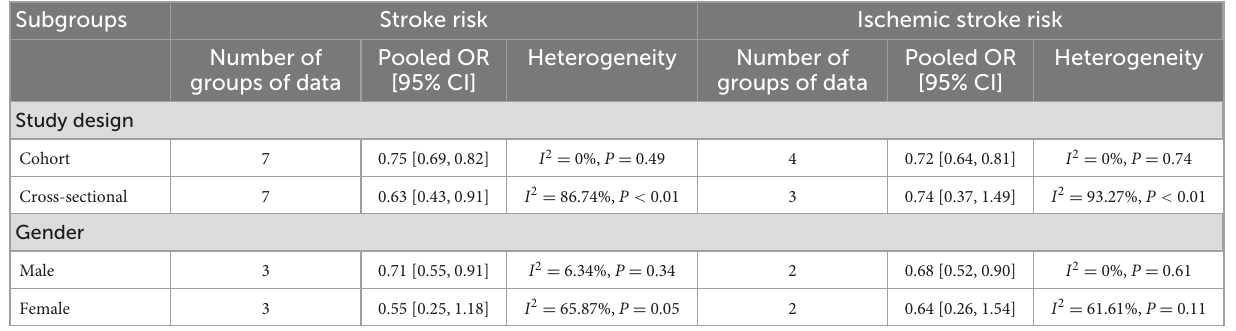
TABLE 2 Subgroup analysis of the correlation between bilirubin level and all stroke or ischemic stroke risk.